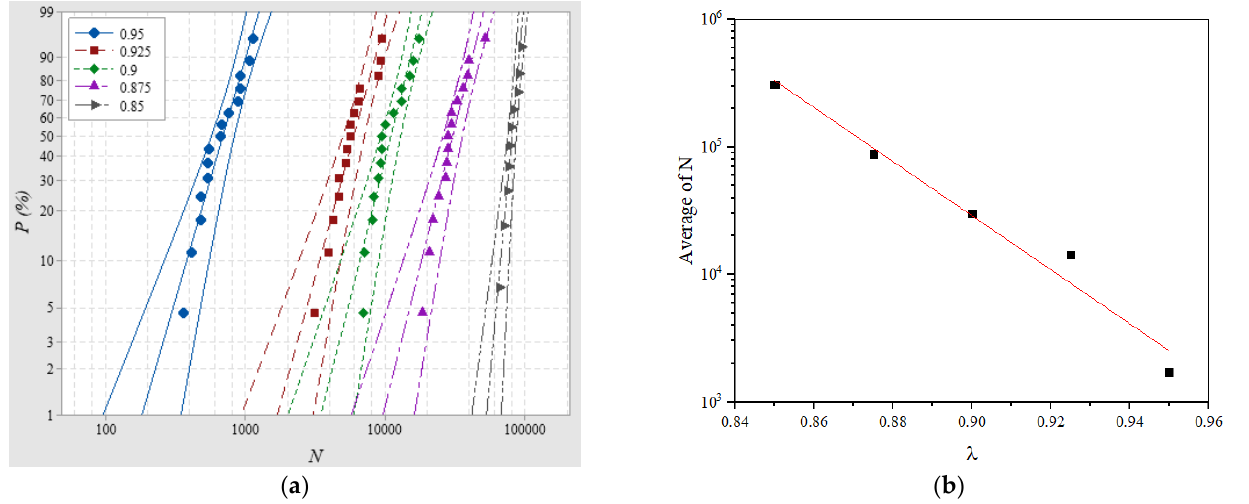
Figure 7. ( a ) SIL distribution and ( b ) average SIL varies with λ .